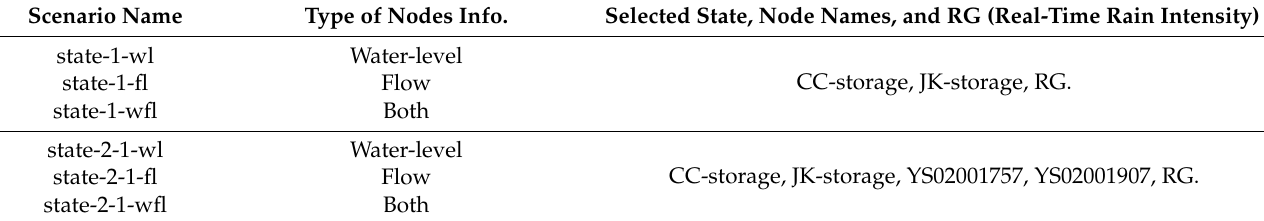
Table 3. The scenarios of state